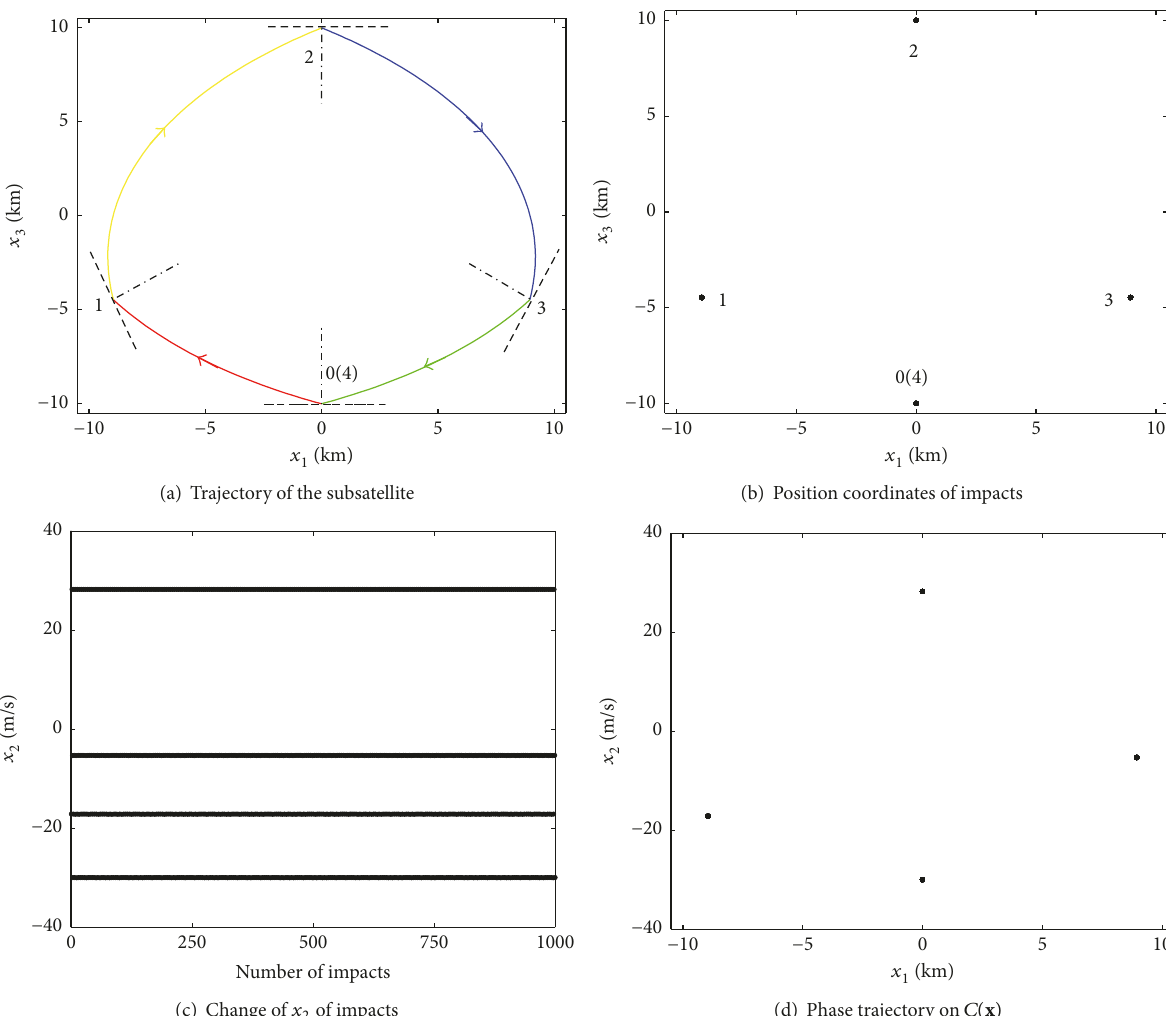
Figure 8: Periodic motion with four